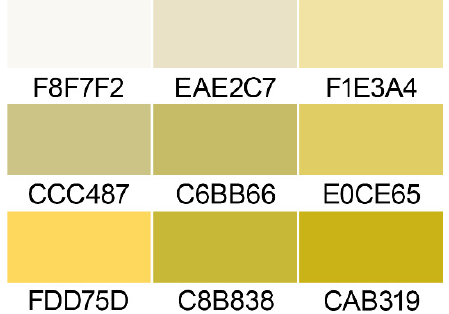
Figure 5. The spectrum of colors of colonies brought down to the 9 most prevalent shades.